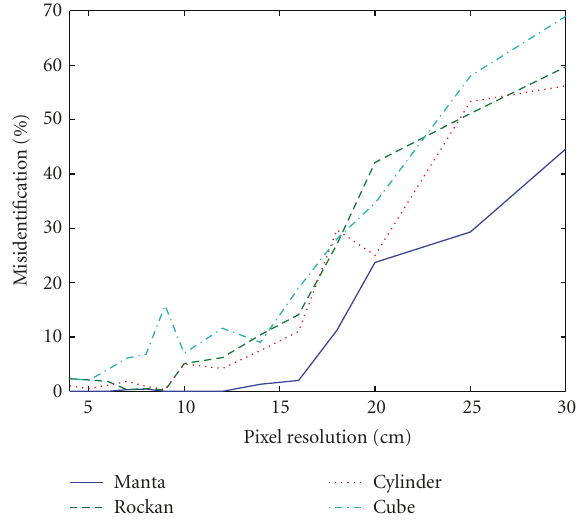
Figure 11: Misidentification of the four targets as a function of the pixel resolution. This is considering the highlight of the